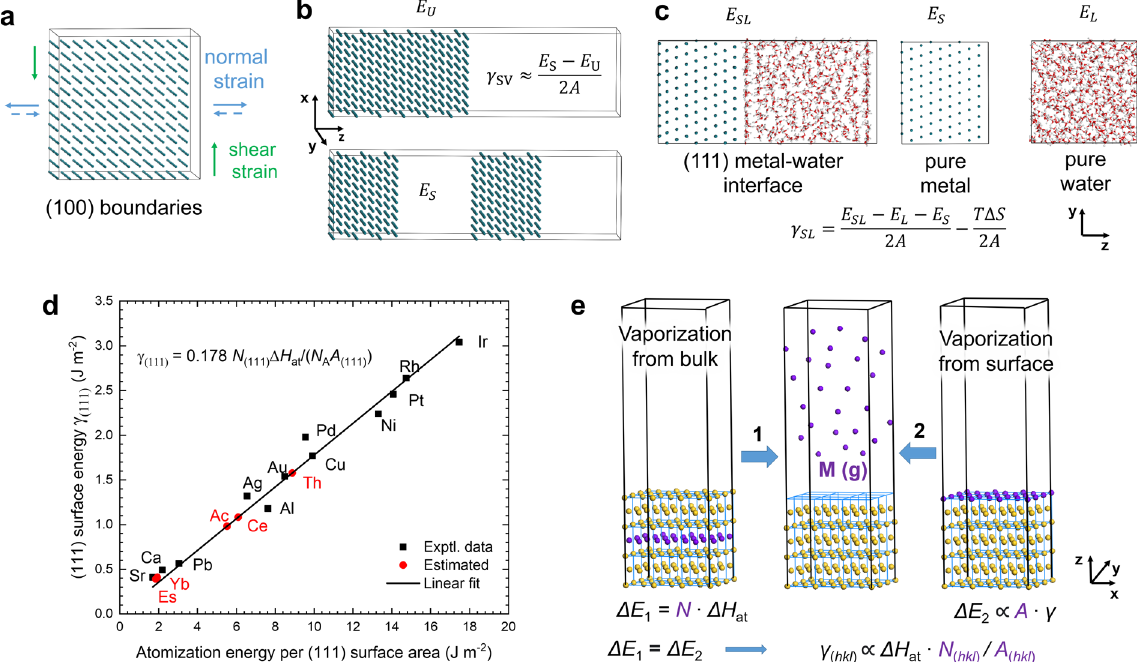
Fig. 1 Calculation of the physical properties in molecular dynamics simulation. a Illustration of the calculation of lattice parameters and mechanical properties of the metals using a cubic 6 × 6 × 6 supercell of Rh (side length 2.282 nm, 864 atoms). The direction of normal strain (blue arrows) and shear strain (green arrows) for the calculation of mechanical properties is indicated. Solid blue arrows = tension, dashed blue arrows = compression. b Illustration of the calculation of the (111) surface energy. (100), (111), and (110) cleavage planes can be generated perpendicular to the vertical axis using the model in a and using equivalent orthorhombic supercells (Supplementary Dataset and refs. 41,96 ). Two boxes with uni fi ed and separate surfaces were used, along with the corresponding average energies E U and E S . c Setup for the calculation of the (111) metal – water interfacial energy. Three boxes containing a metal – water interface ( E SL ), pure water ( E L ), and pure metal ( E S ) were used. d Linear relationship between surface energy and atomization energy. The (111) surface energy is proportional to the atomization energy normalized per (111) surface area for all fcc metals. The relationship was used to estimate the unknown surface energies for Es, Yb, Ac, Ce, and Th (red data points). e Derivation of the relation in d . Atomization of a layer of atoms from the bulk (process 1) and removal of a layer of surface atoms (process 2) are thermodynamically equivalent. Process 1 describes atomization. The equivalent process 2 creates a new surface of energy γ , plus it disconnects all bonds between neighbor atoms in the detached atomic layer. These additional contributions lead to an atomization energy per surface area that is several times higher than the surface energy (see x axis versus y axis in d ).